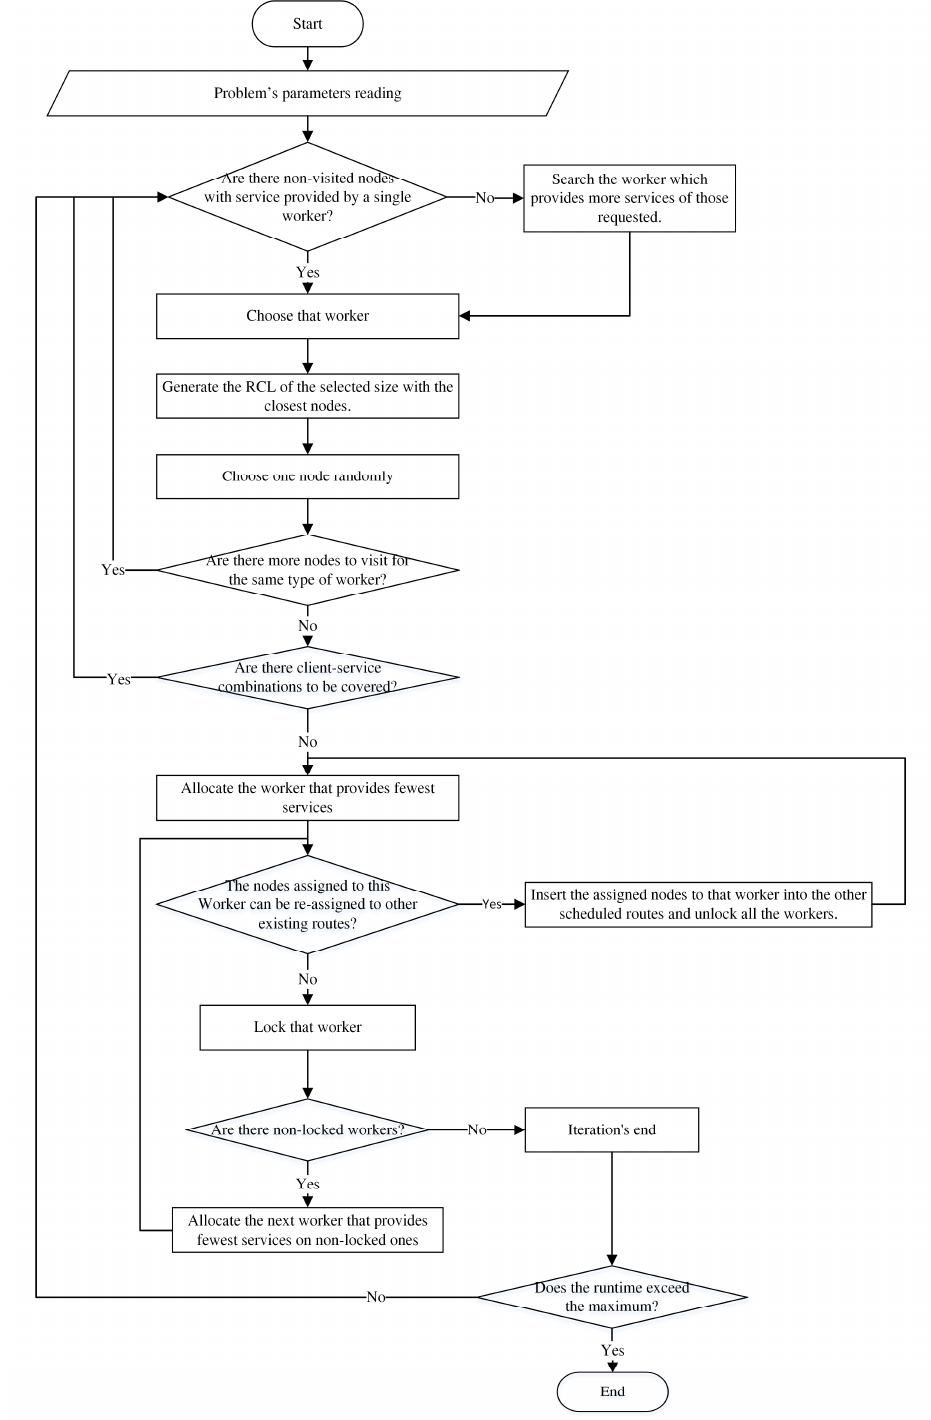
Fig. 2. Algorithm for the